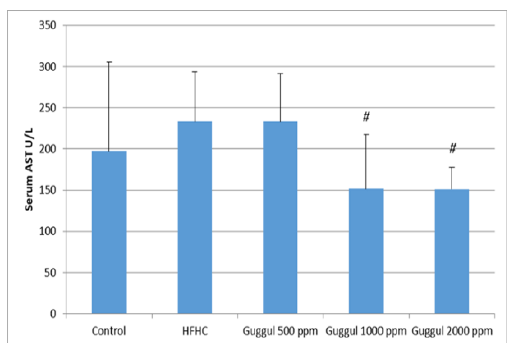
Figure (5) Effects of guggulsterone on serum AST level of mice models with high-fat diet induced